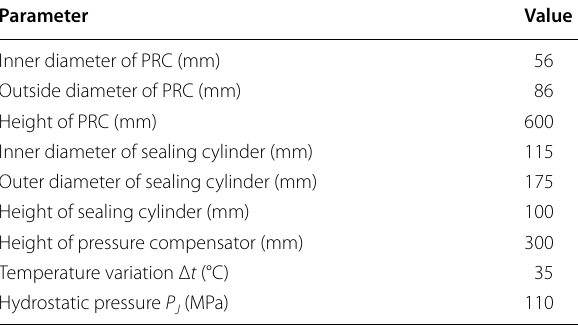
Table 1 Design parameters of GTSS